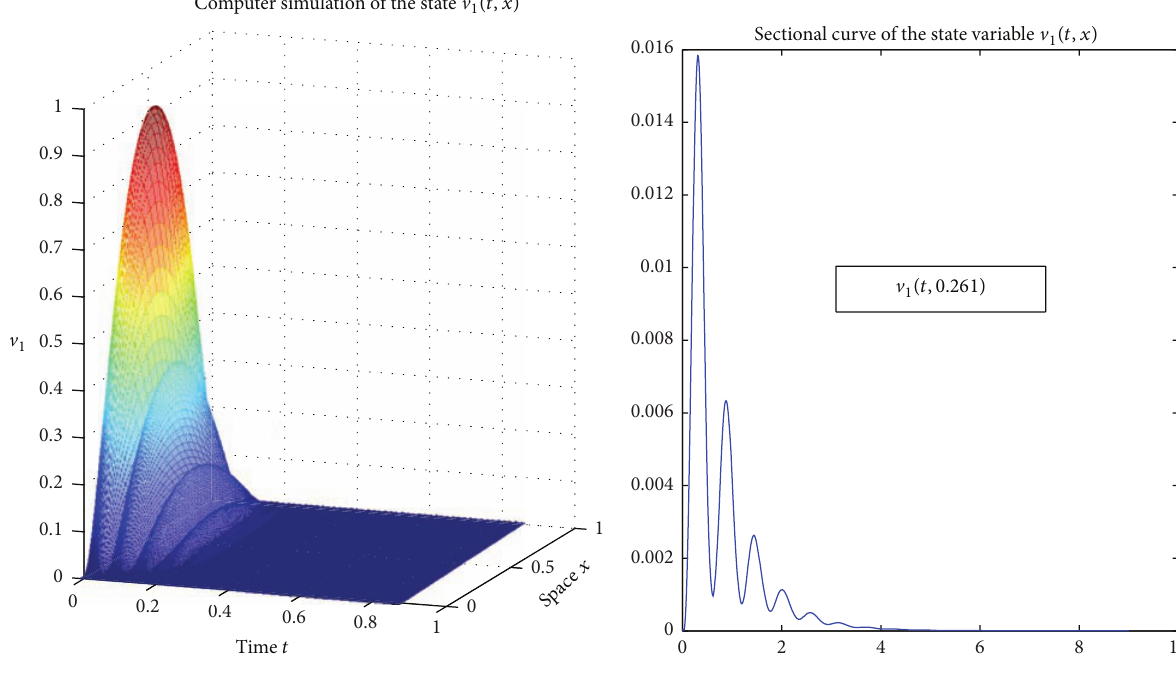
Figure 1: The state variable V 1 (𝑡,𝑥) .